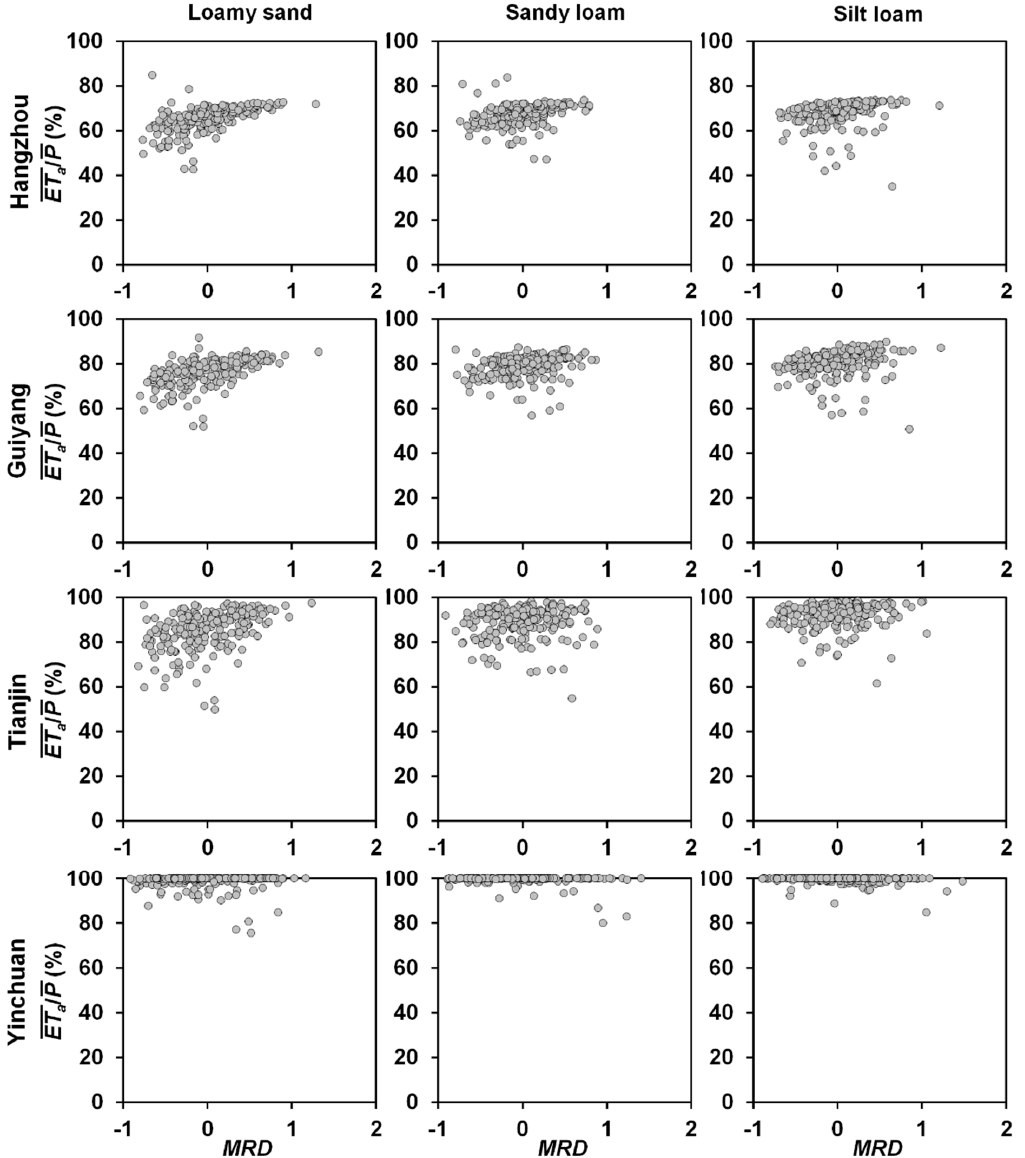
Figure 4 . Relationships of mean relative difference ( MRD ) of soil moisture with mean annual ratio of Figure 4. Relationships of mean relative di ff erence ( MRD ) of soil moisture with mean annual ratio of actual evapotranspiration ( ET a ) over precipitation ( P Table 4 . Spearman’s rank correlation coefficients of mean relative difference ( MRD ) of soil moisture with mean annual ratios of actual evapotranspiration ( 𝐸𝑇 (cid:3028) (cid:3364)(cid:3364)(cid:3364)(cid:3364)(cid:3364) ) and groundwater recharge ( 𝐺𝑅(cid:3364)(cid:3364)(cid:3364)(cid:3364) ) over precipitation ( 𝑃 (cid:3364) ).